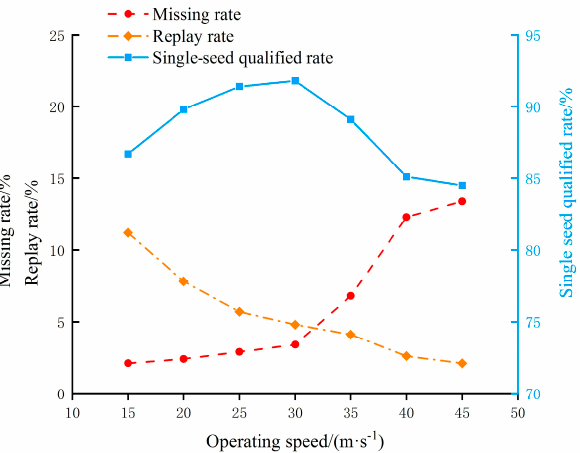
Figure 14. Relationship with evaluation indicators under different operating